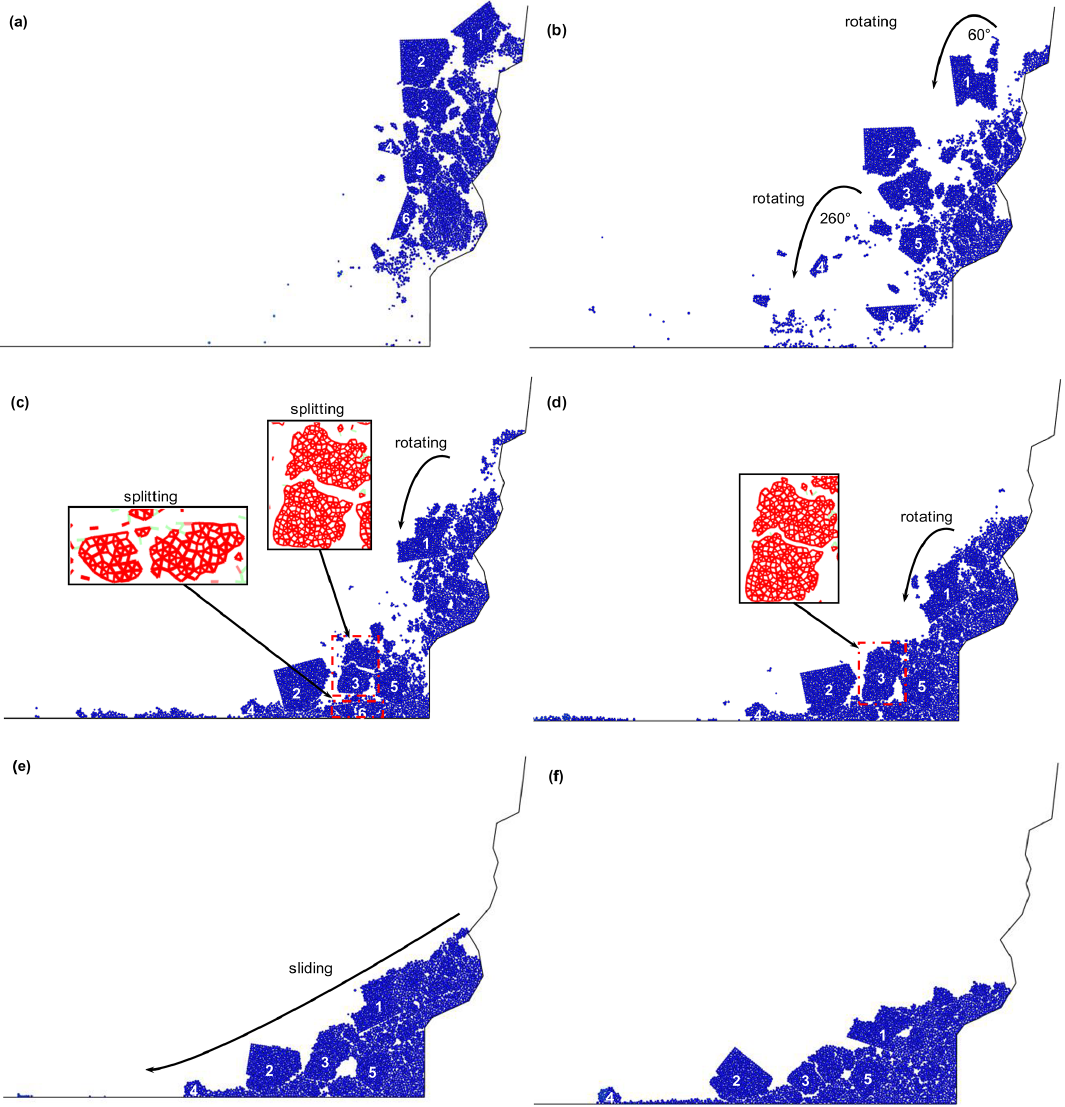
Figure 10. Failure and accumulation process of the rock slope. The time steps of (a)–(f) are 5 × 10 4 , 2 × 10 5 , 4 × 10 5 , 8 × 10 5 , 1 . 6 × 10 6 , and 3 . 2 × 10 6